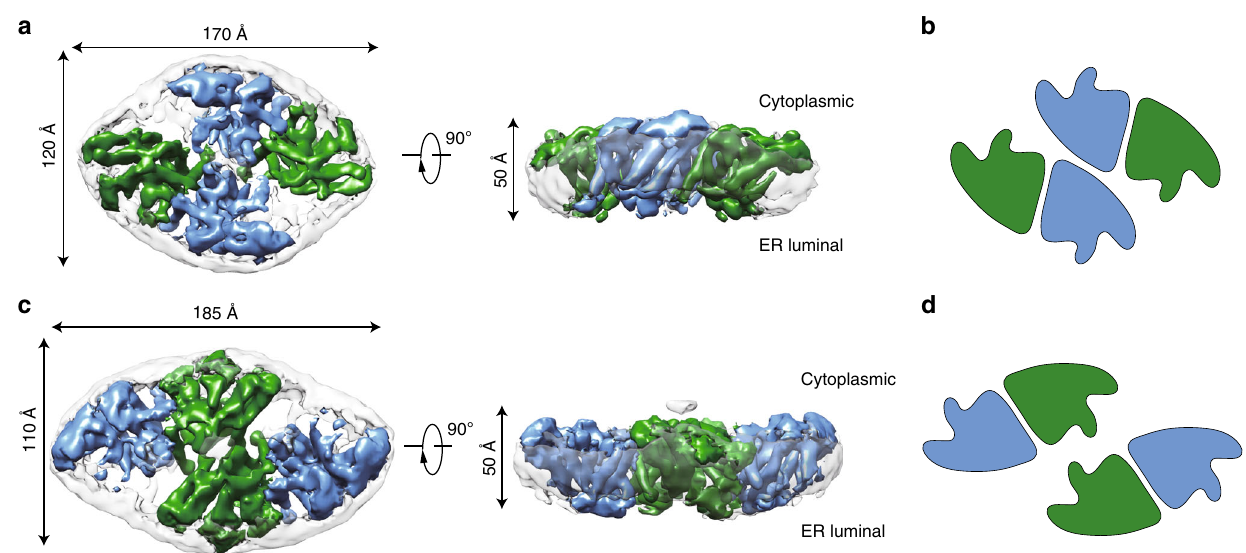
Fig. 2 Cryo-EM maps of the human SOAT1 tetramer. a Cryo-EM density map of the oval-shaped hSOAT1 tetramer in top view and side view. Two subunits in one hSOAT1 dimer are colored in green and blue, respectively. Densities of the MSP and lipids in nanodiscs are colored in gray with semi- transparency. b The domain arrangement of oval-shaped hSOAT1 tetramer is shown in a cartoon model in top view. Each subunit is colored the same as in a . c The density map of the rhombic-shaped hSOAT1 tetramer is shown in top and side view. d The domain arrangement of rhombic-shaped hSOAT1 tetramer in top view. Each subunit is colored in the same way as in c